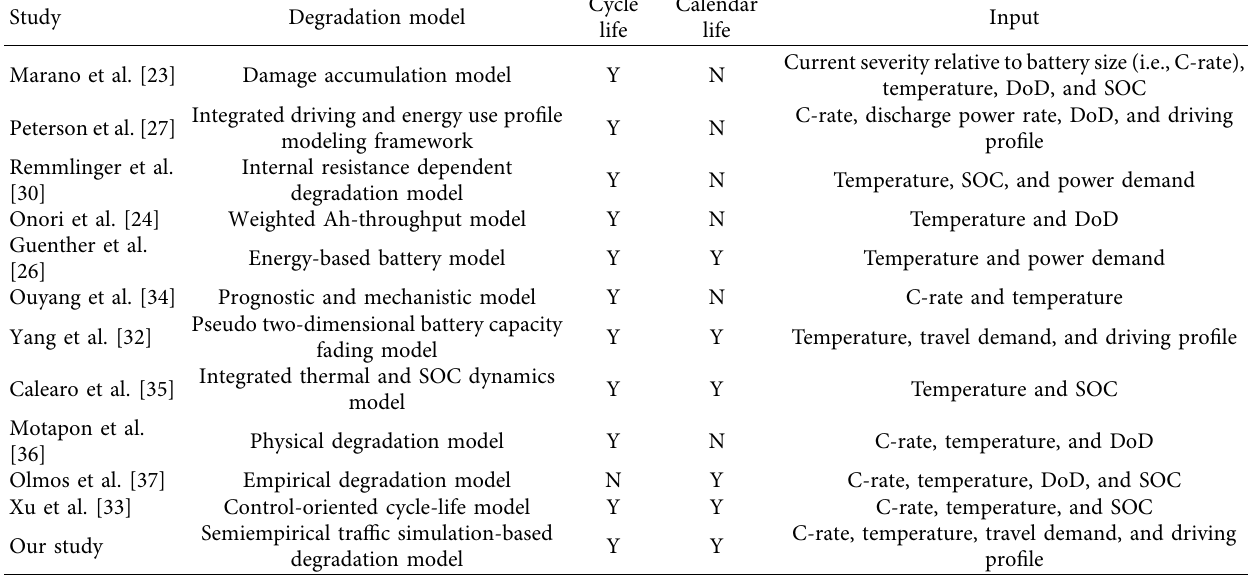
Table 1: Summary of the literature on battery degradation